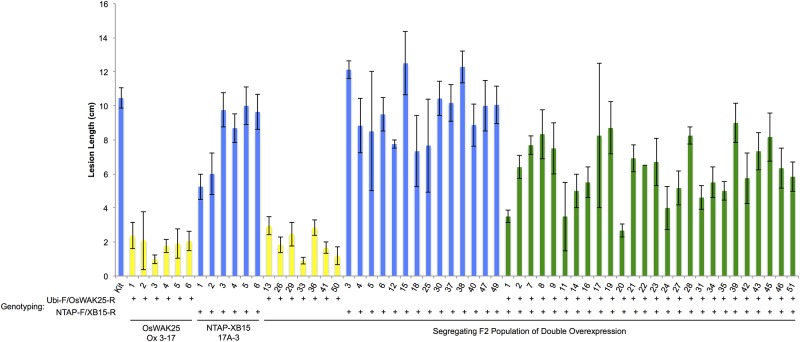
Genetic segregation of OsWAK25/XB15 double overexpression F2 progeny.51 F2 progeny independently segregating for OsWAK25 overexpression and XB15 overexpression were challenged with PXO99 using scissors inoculation along with Kitaake and parental lines as controls. Lesions were measured 14 dpi. Each bar represents the average and standard error of at least three leaf measurements. Measurements were pooled by genotype and analyzed with an ANOVA followed by the Tukey-Kramer significance test. Different colors indicate statistical significance from the other genotypes.